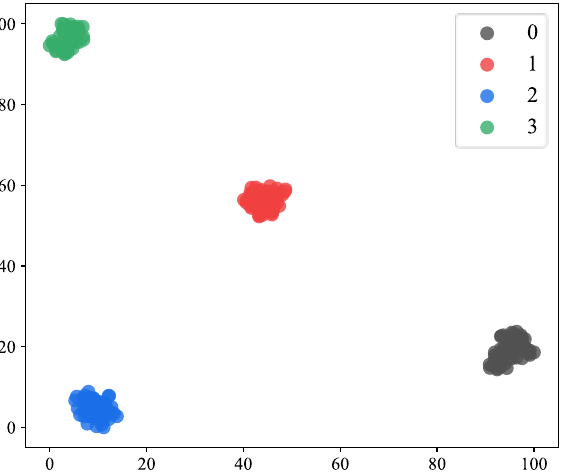
Figure 13. Simulation experimental training process of CSAM-MSCNN: ( a ) Loss function curve; ( b ) accuracy curve.